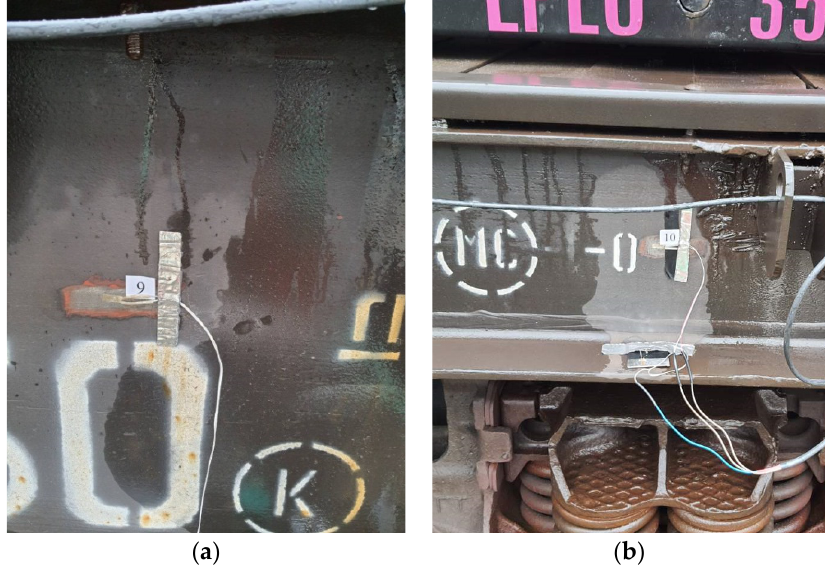
Figure 11. Strain gauges on the main longitudinal beam of the flatcar: ( a ) middle part; ( b ) end part. Some strain gauges were installed on the automatic coupler to determine the impact force of it (Figure 12a). Besides, the accelerations of the flatcar frame and, therefore, the impact force, were determined with an acceleration indicator attached to the bearing structure of the flatcar (Figure 12b).